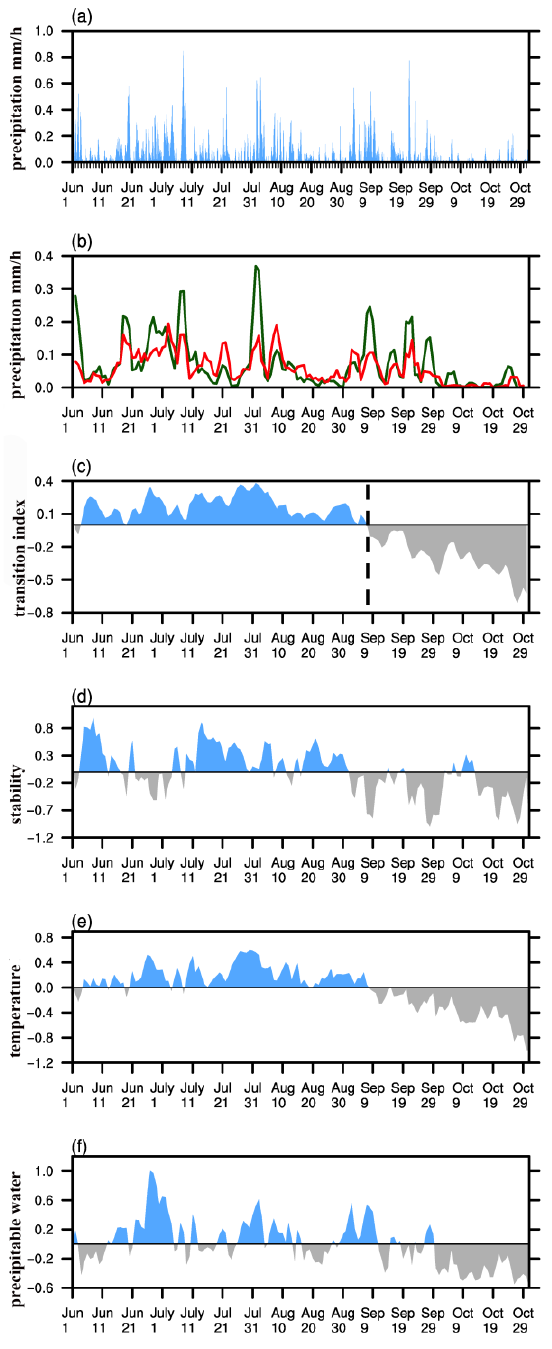
Figure A7. For June–October 2015, ( a ) hourly domain (white box in Figure 1a) averaged precipitation; ( b ) 3-day running mean of nighttime (20:00–08:00, dark green line) and daytime (08:00–20:00, red line) rainfall; ( c ) 3-day running mean of transition index anomaly (TI); normalized domain averaged ( d ) atmospheric stability anomaly, ( e ) 2 m temperature anomaly, and ( f ) precipitable water anomaly. The black dashed line in ( c ) indicates transition date 7 September 2015.